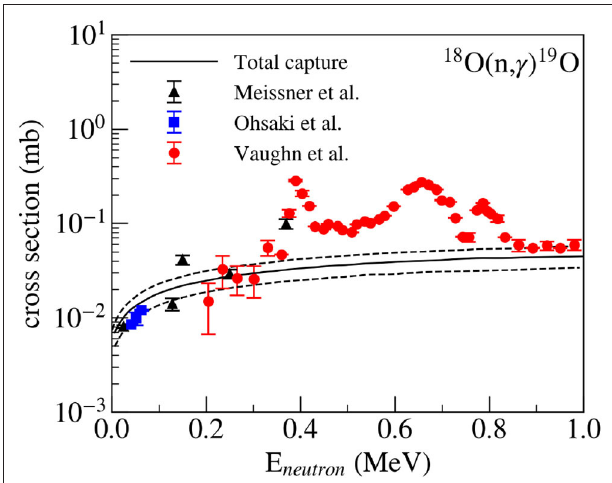
FIGURE 10 | Comparison of the cross-section of the direct radiative neutron capture 18 O(n, γ ) 19 O determined by the ANC method from the 18 O(d,p) 19 O reaction with experimental data of Vaughn et al. (1965), Meissner et al. (1996), and Ohsaki et al. (2008). Dashed lines show the uncertainty band